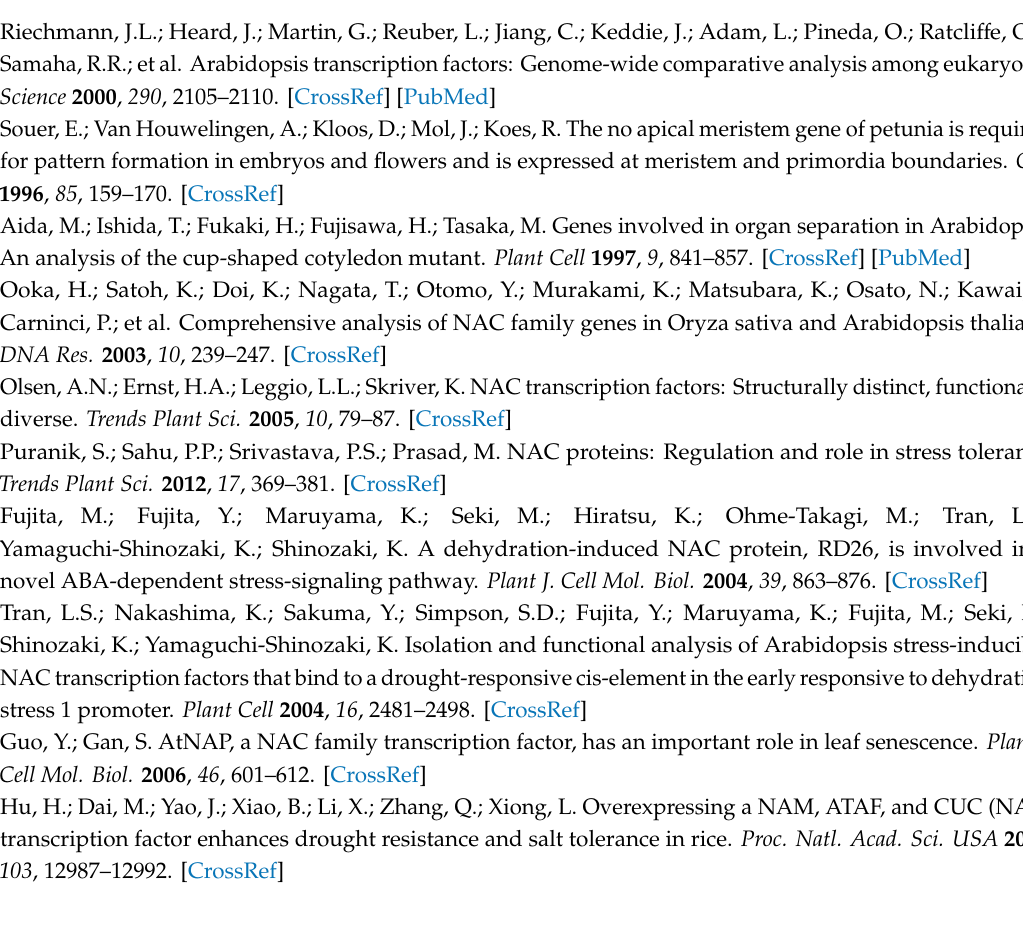
Figure S1. Exact sequence structure corresponding to structural pattern in Figure 3. Figure S2. Sequence logos of Motifs 1–11 (except Motif 9) that had ≥ 5 sites. Figure S3. Conserved WV[L / V]CR amino acid residues of Motif 7 in sequences of Subgroups 6 and 7. Table S1. Various details of 559 reidentified high-quality TaNAC transcripts from IWGSC RefSeq v1.1. Table S2. Di ff erential expression of 154 unigenes annotated as NAC candidates from RNA-seq data of N9134 infected with Pst and Bgt . Table S3. Various details of 186 TaNAC transcripts obtained from N9134 infected with Pst and Bgt . Table S4. Conformity test of ratio of normal and abnormal coding in TaNAC transcripts between two classifications of DEGs / non-DEGs under fungal stress. Table S5. Primers used for cloning TaNAC genes. Table S6. Primers used for